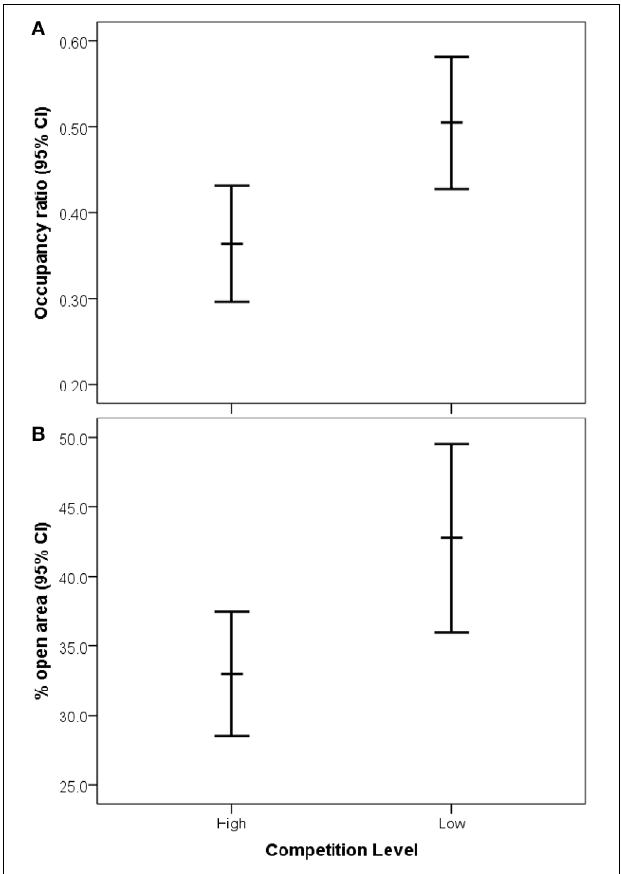
FIGURE 3 | Relationship between (A) eastern bluebird occupancy (number of years occupied) and (B) percentage of open area (grassland/agriculture) within bluebird territories in low and high competition zones on settlement (95% CI for the mean).